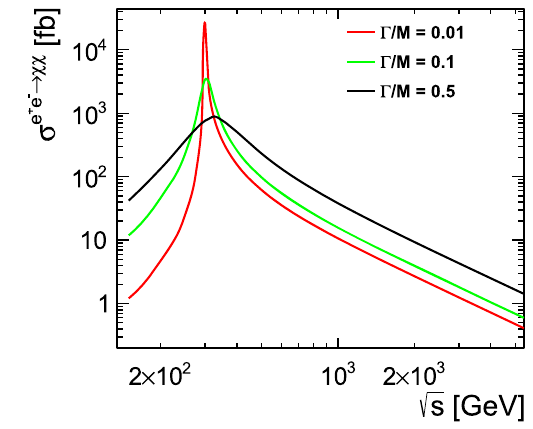
Fig. 1 Cross section for DM production in e + e − collisions as a func- √ s . Expectations for pair production of tion of the collision energy light Dirac DM ( m χ = 50GeV) are shown for the scenario with vector mediator of 300GeV and different mediator widths, as indicated in the plot. The mediator coupling to electrons is set to 0.01